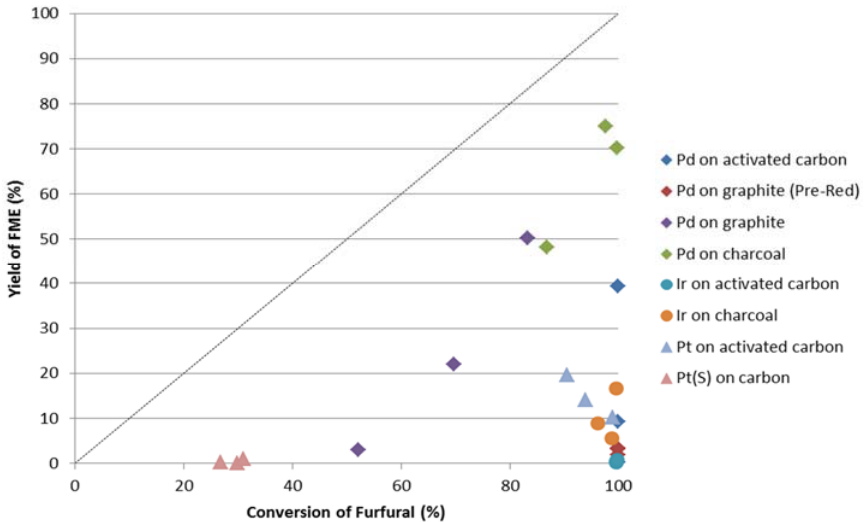
Figure 4. Yield percentage to 2-methoxymethylfuran vs. conversion of furfural for noble metals with 5% w / w metal loading. Dashed line represents 100% selectivity to